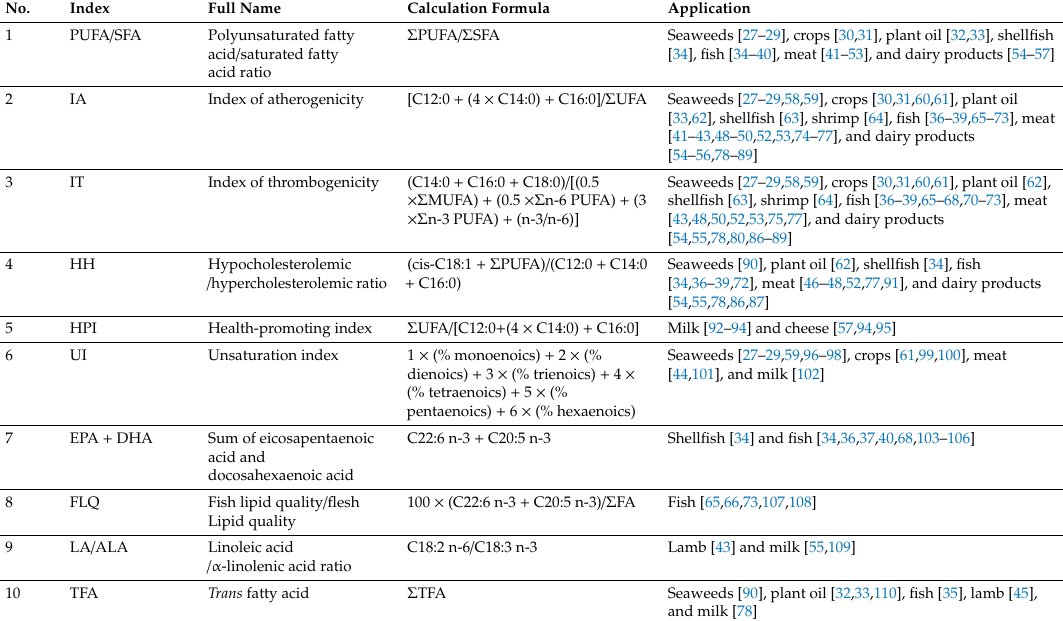
Table 1. Summary of nutritional